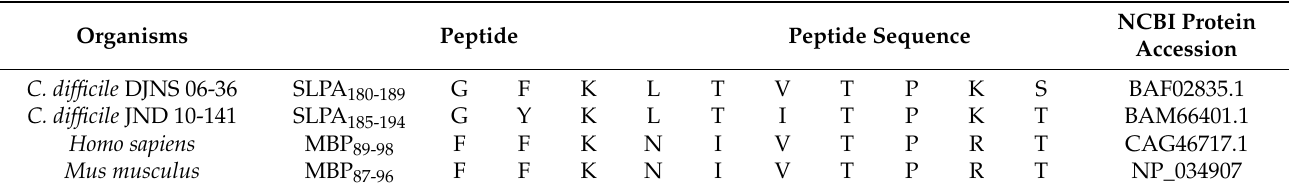
Figure 1. SLPA expressed by C. difficile DJNS06-36 possesses an MBP mimotope for DR2a-restricted MBP 89-98 -specific T cells. ( A ) Proliferation of DR2a-restricted MBP-specific Tg T cells in response to synthetic enteric bacteria peptide sequences. Mean of two experiments is presented. ( B ) Difference in DNA sequence for the MBP mimotope between C. difficile DJNS06-36 and C. difficile JND10-141. ( C ) Synthetic C. difficile DJNS06-36 SLPA 180-189 peptide mimotope of MBP 89-98 for proliferation of DR2a-restricted MBP-specific T cells in comparison to MBP 89-98 and synthetic C. difficile JND10-141 SLPA 185-194 peptide. Data from one representative experiment of three independent experiments is presented.